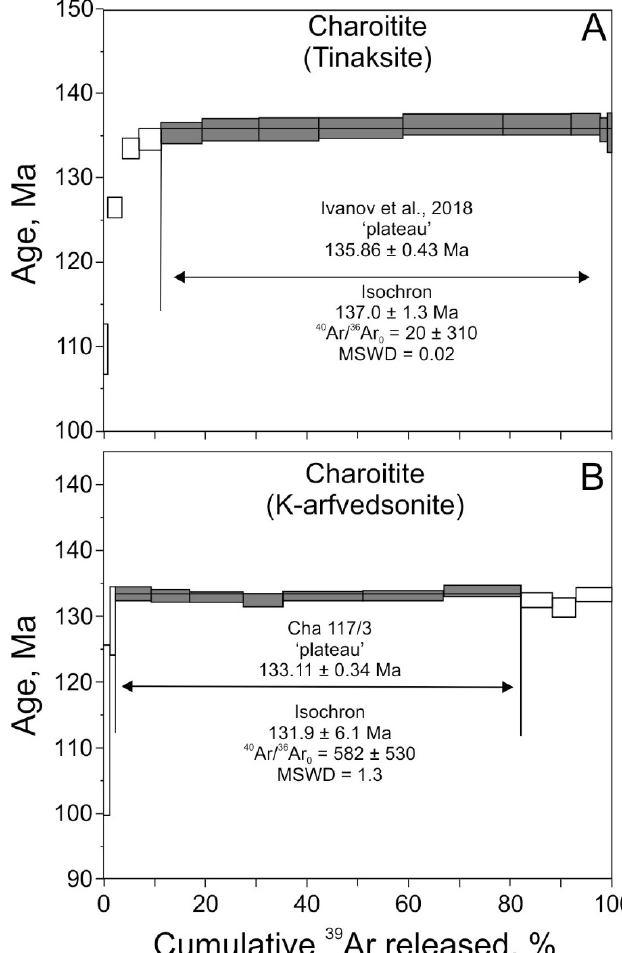
Figure 11. Argon release spectra for two different minerals of charoitites: ( A ) Tinaksite (NaK 2 Ca 2 TiSi 7 O 19 (OH)) of a museum charoitite sample analyzed in [40]; and ( B ) K-arfvedsonite analyzed in this study. Steps used for calculation of plateau and isochron age values are shadowed.